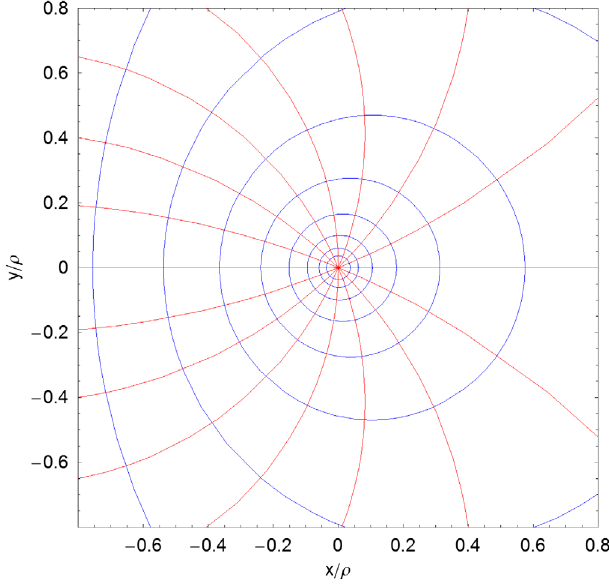
FIG. 1. Toroidal coordinates. The red curves show lines of constant v from 0 to 2 π . The blue curves show lines of constant value for the coordinate u in the range 0.5 – 4 in steps of 0.5, with 0 ≤ v < 2 π . Larger values of u give circles of smaller diameter; in the limit u → ∞ , the circles converge towards the reference trajectory x ¼ y ¼ 0